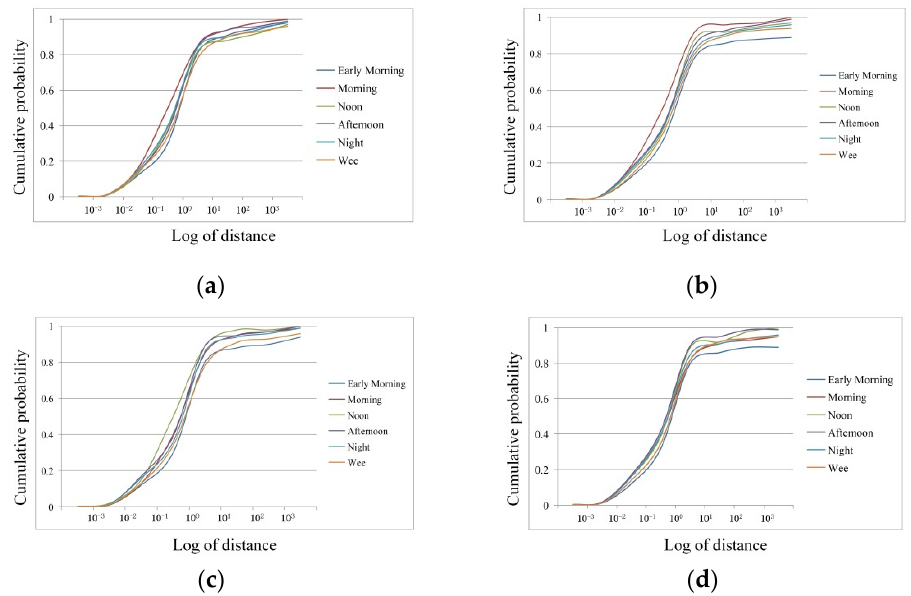
Figure 4. CDF of Dis between next Check-ins POIs on Weekday and Weekend: ( a ) Weekday’s CDF on Foursquare; ( b ) Weekday’s CDF on Yelp; ( c ) Weekend’s CDF on Foursquare; ( d ) Weekend’s CDF on Yelp.